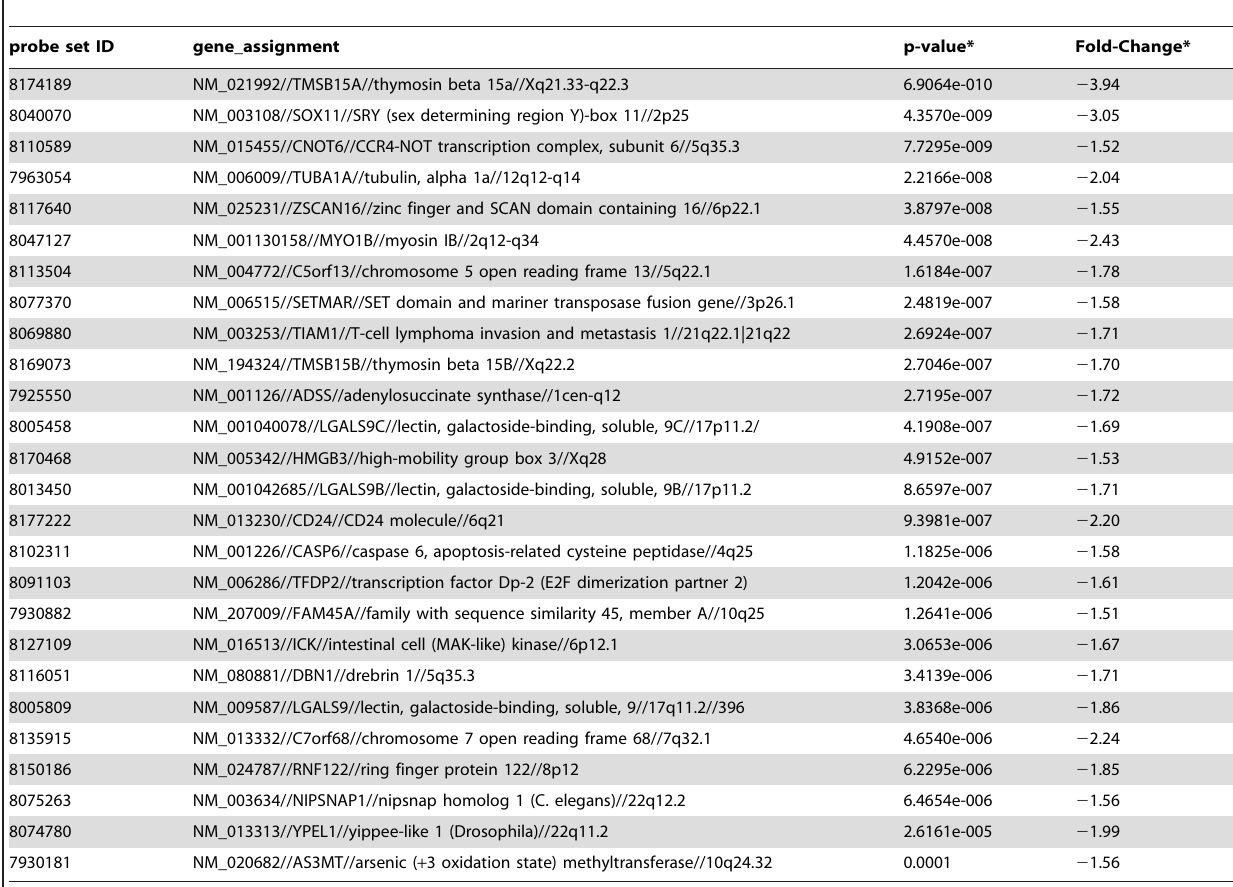
Table 1. Differently expressed genes after SOX11 knockdown by siRNA in Granta 519 cells # .